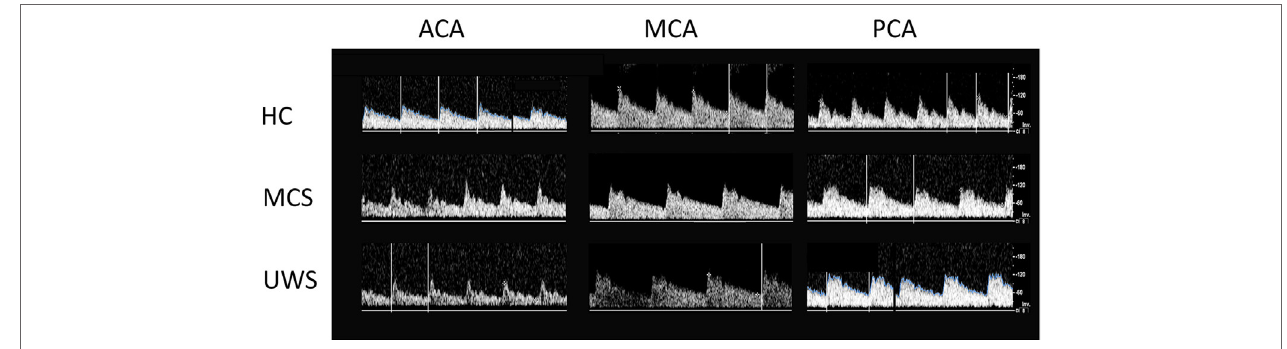
FigUre 4 | Shows the transcranial Doppler waveforms (on the right) from left middle (MCA), anterior (ACA), and posterior (PCA) cerebral arteries at rest in a representative subject for each group (HC, MCS, and UWS). Flow velocity (in centimeter per second, right vertical bar) are